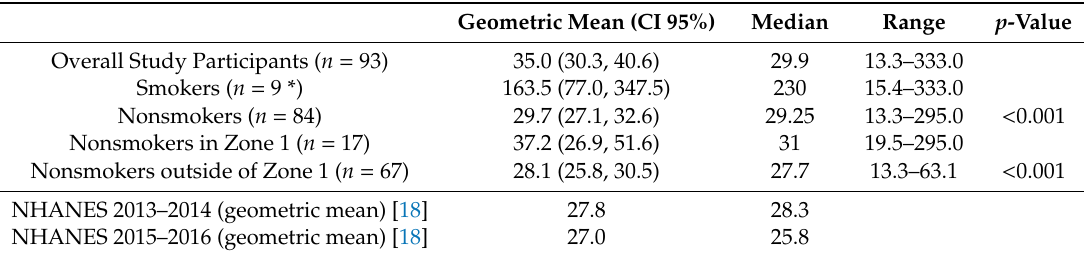
Table 2. HbEO adduct results (in pmol / gmHb) by exposure and compared to US NHANES.